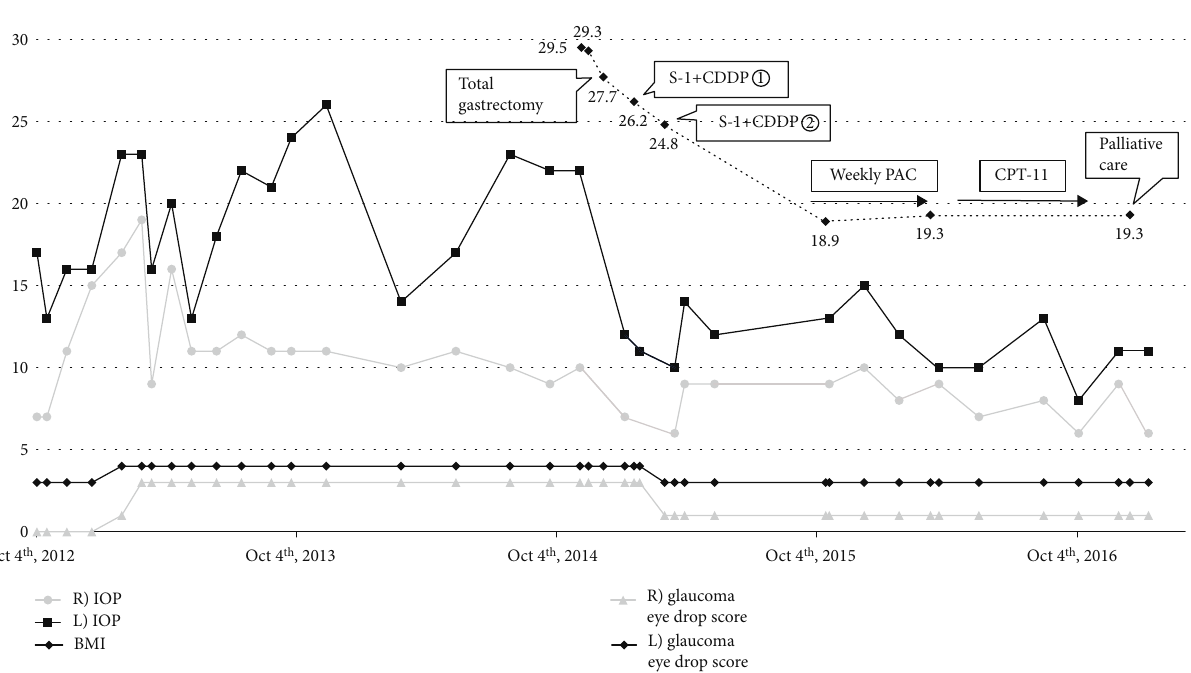
Figure 1: The course of changes in intraocular pressure, body mass index, and glaucoma eye drop score. Vertical axis: mmHg (intraocular pressure), points (glaucoma eye drop score), and body mass